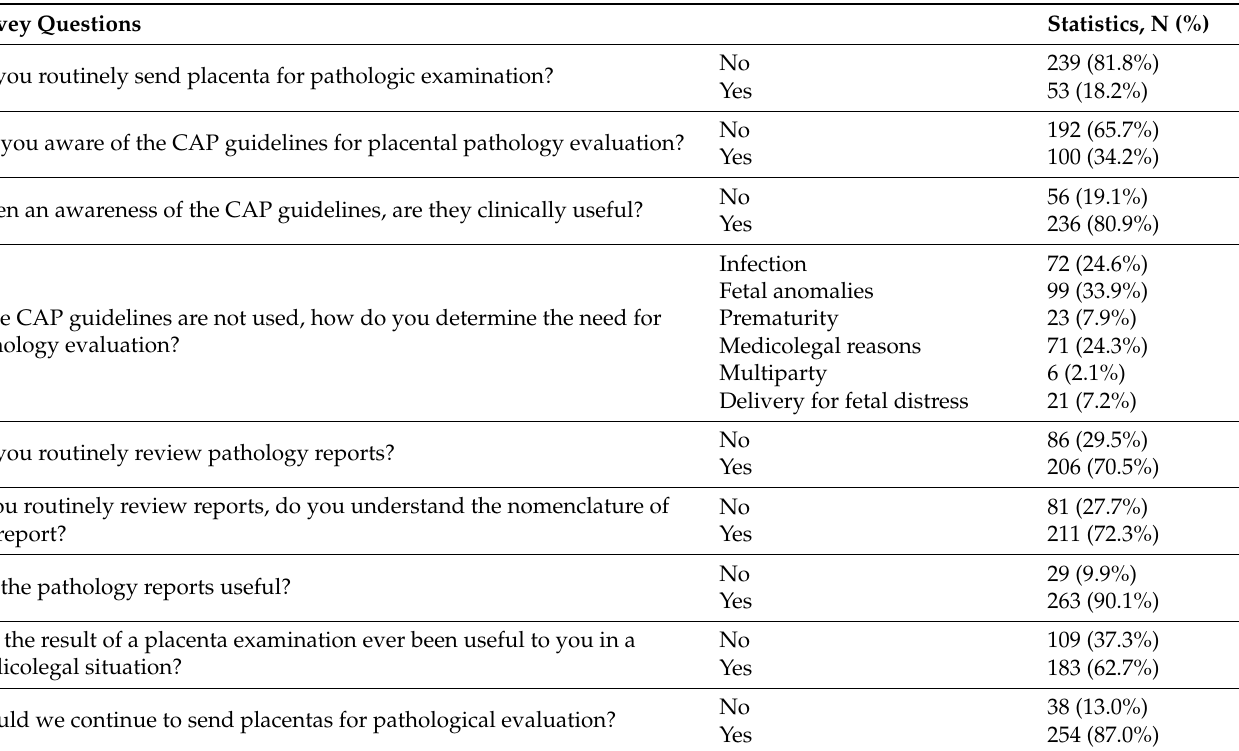
Table 3. Descriptive statistic of the pathologic examination survey questions.